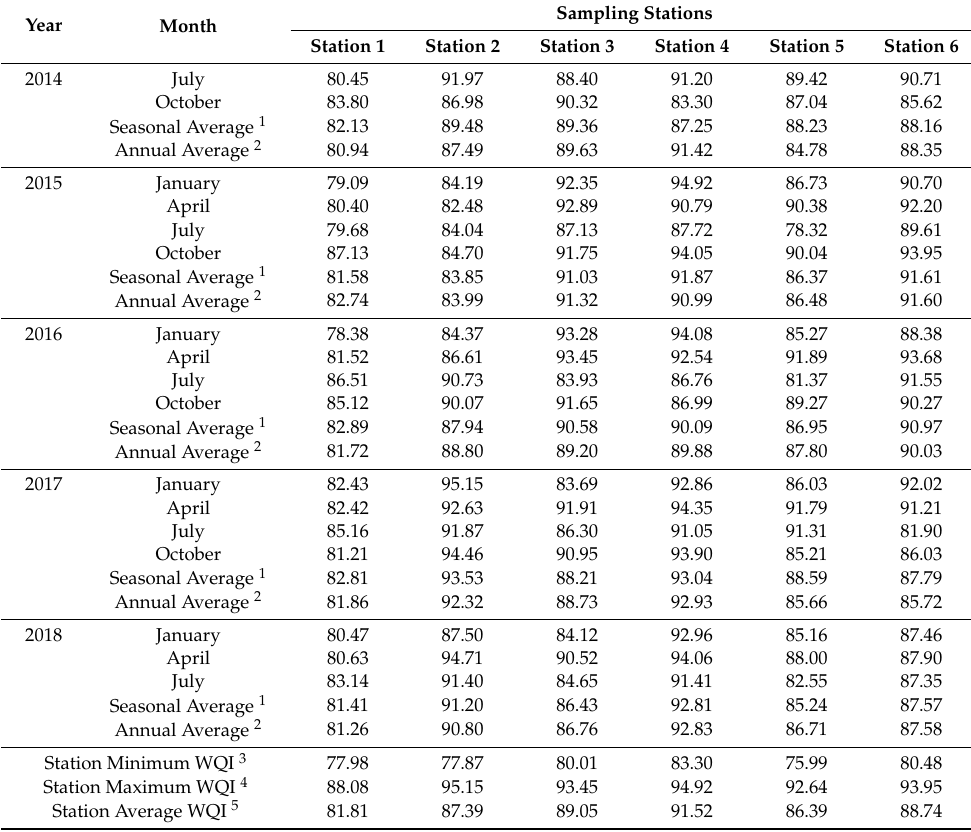
Table 7. Water quality index matrix for the six sampling stations.